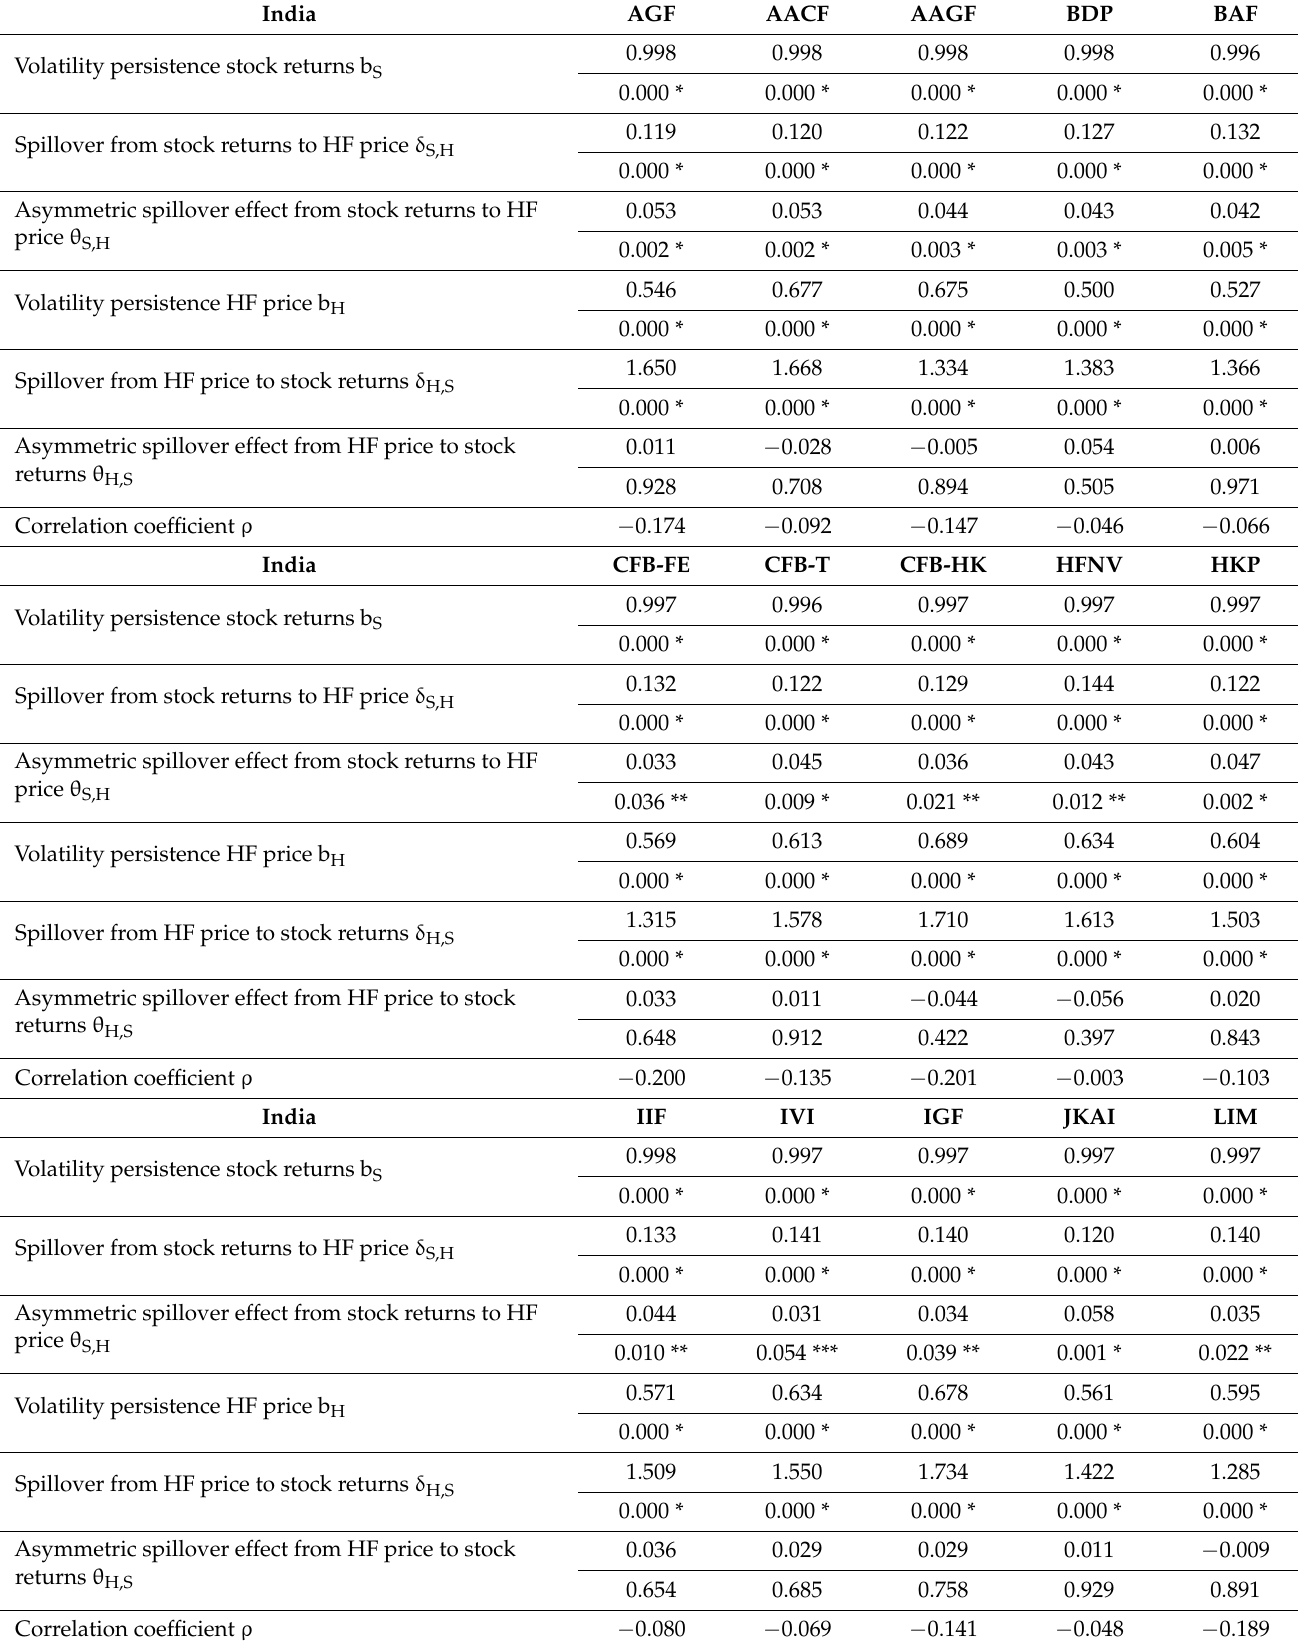
Table 6. Volatility Spillover Between the Indian Stock Market (NSE500) and Hedge Fund